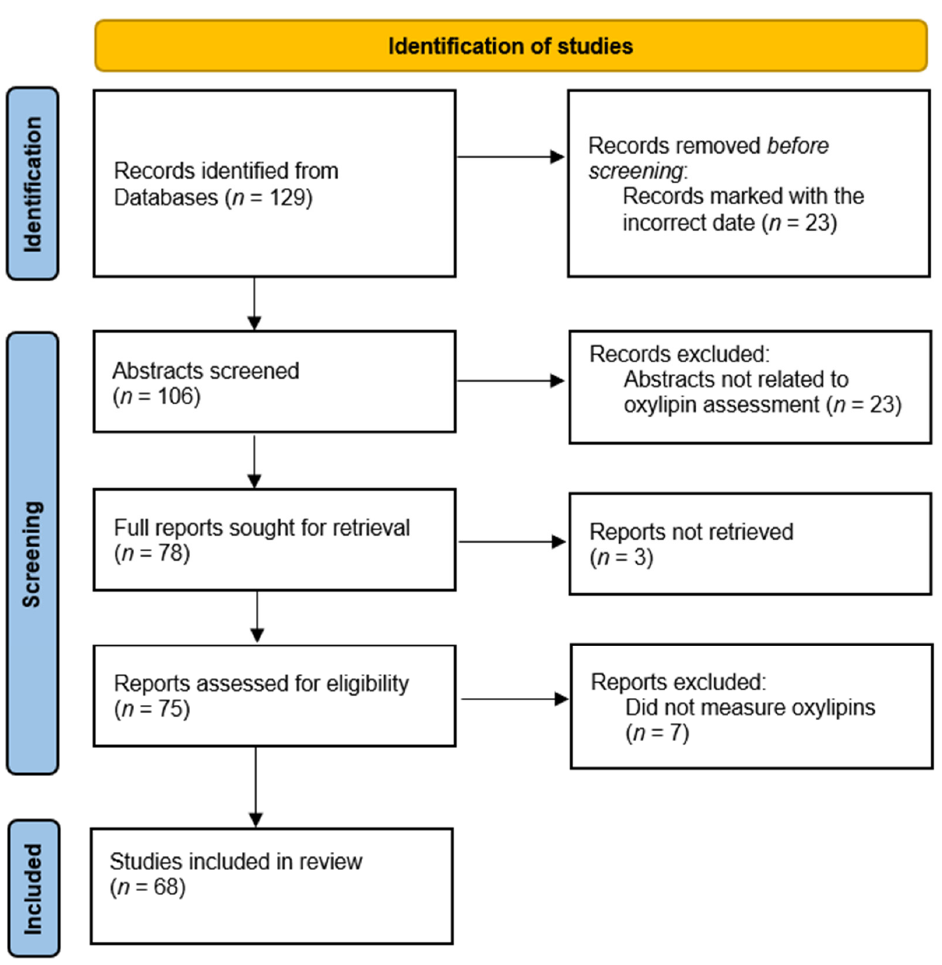
Figure 1. PRISMA Table for Study Identification. PRISMA table shows the process for identifying records to include in our survey of publications, reproduced from the 2020 PRISMA guidelines [25].